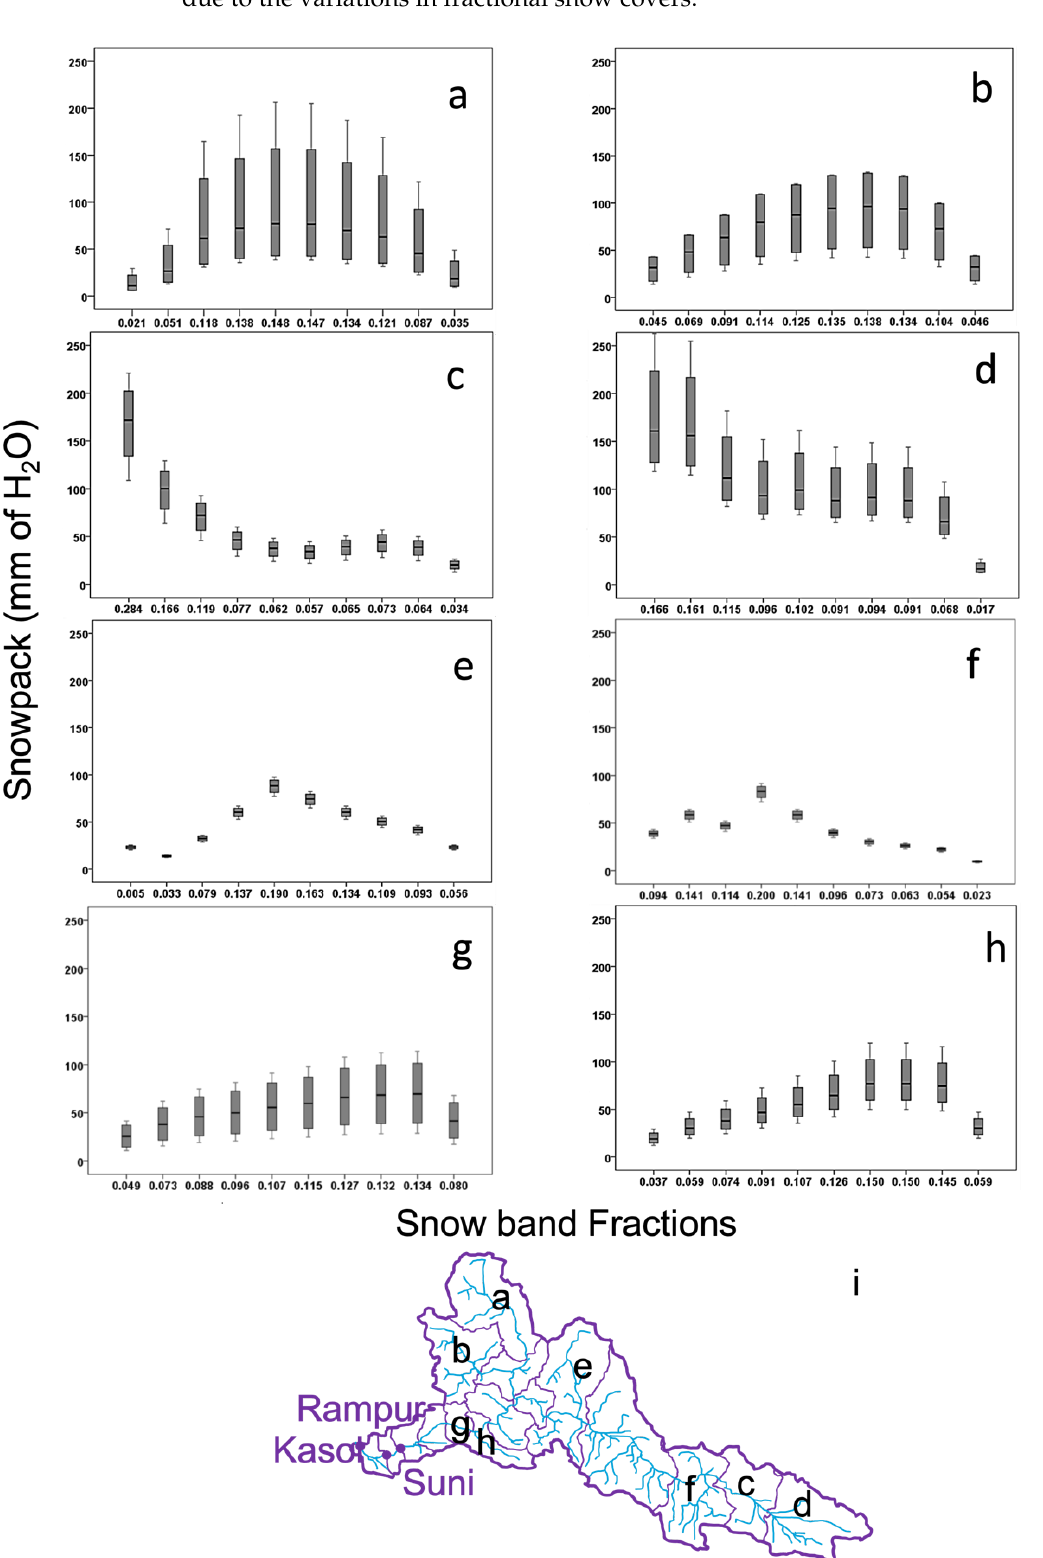
Figure 6. Sub-catchment snowpack changes computed as per elevation bands during whole time series (1991–2030): ( a ) SB1; ( b ) SB2; ( c ) SB15; ( d ) SB16; ( e ) SB5; ( f ) SB7; ( g ) SB8; ( h ) SB9; ( i ) sub-catchment location of the stations above. Selected sub-catchment respond to for distinct patterns across the Satluj River Basin.